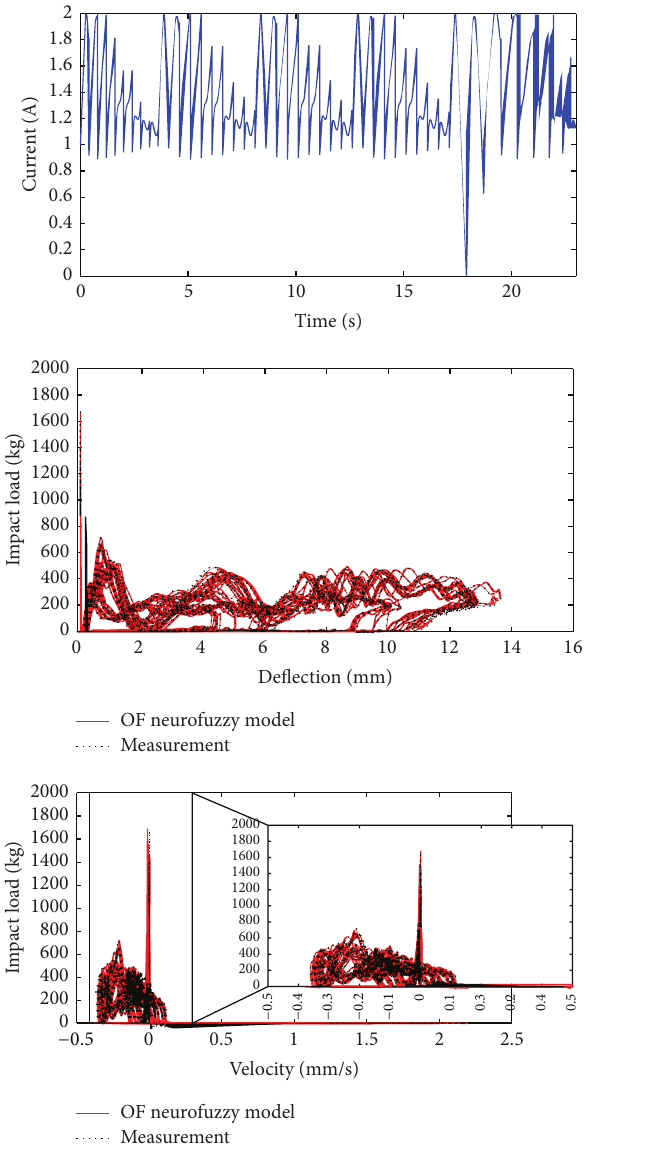
Figure 23: Impact load-displacement and impact load-velocity curves: different drop release heights and random current